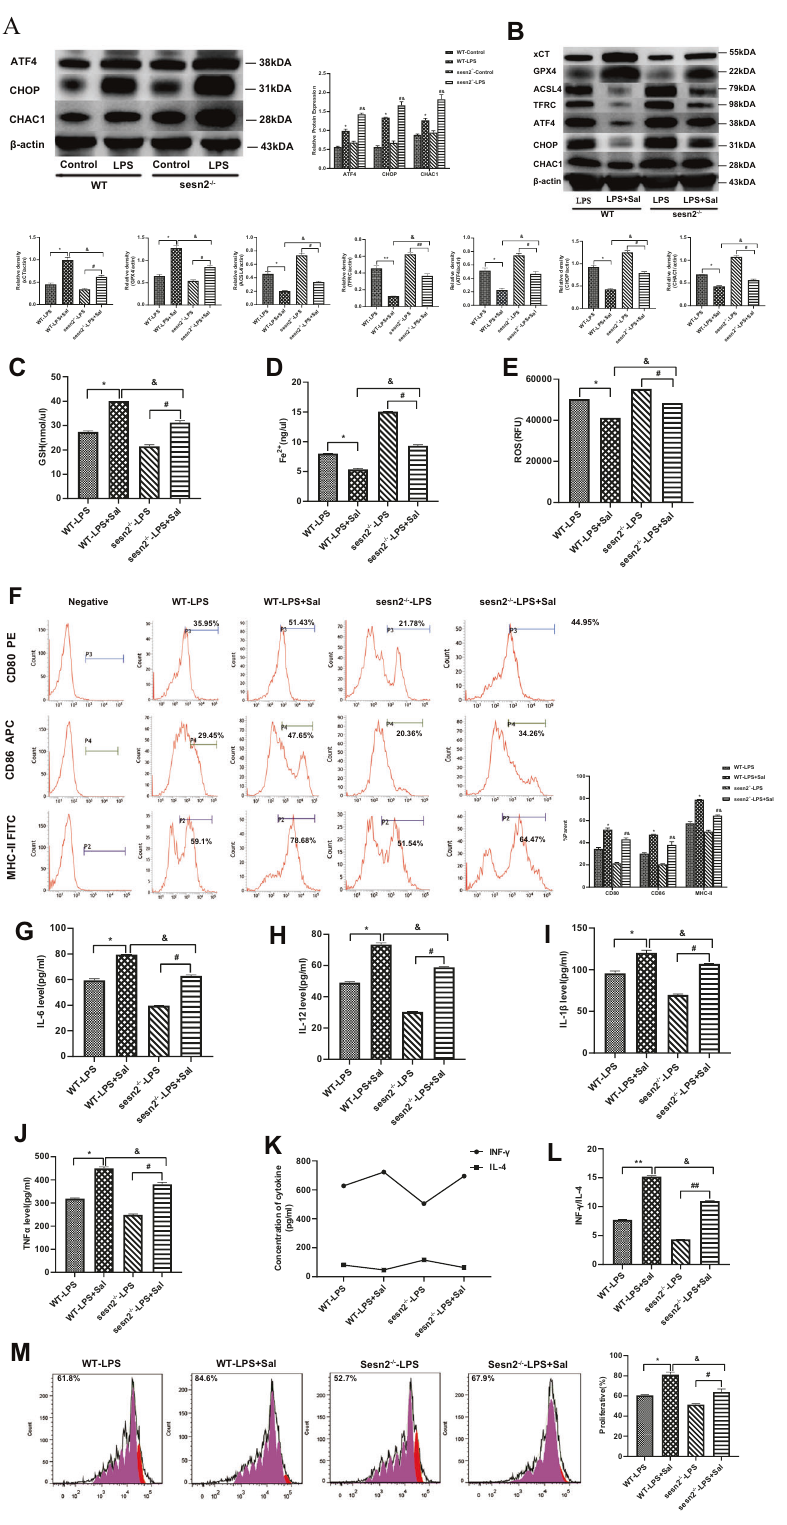
Isolation of splenic DCs and CD4 + T cells Spleens in mice were isolated followed by being triturated with gemfree instruments. Mononuclear cells were extracted with lymphocyte isolation fl uid. Then, they were magnetized by cocktails of biology-conjugated antibodies with the concentration of 10 μ l per 10 7 cells, respectively, including CD4 + T-cell antibody and CD11c + antibody at 4°C for 10min.